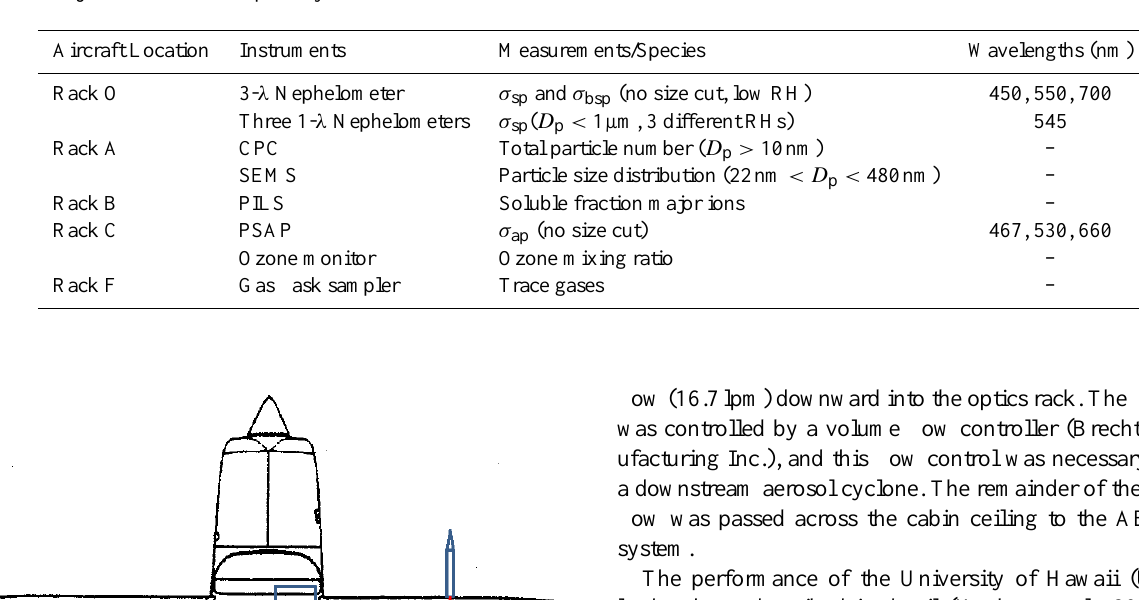
Table 1. Major instruments and primary measurements on the AAO aircraft.